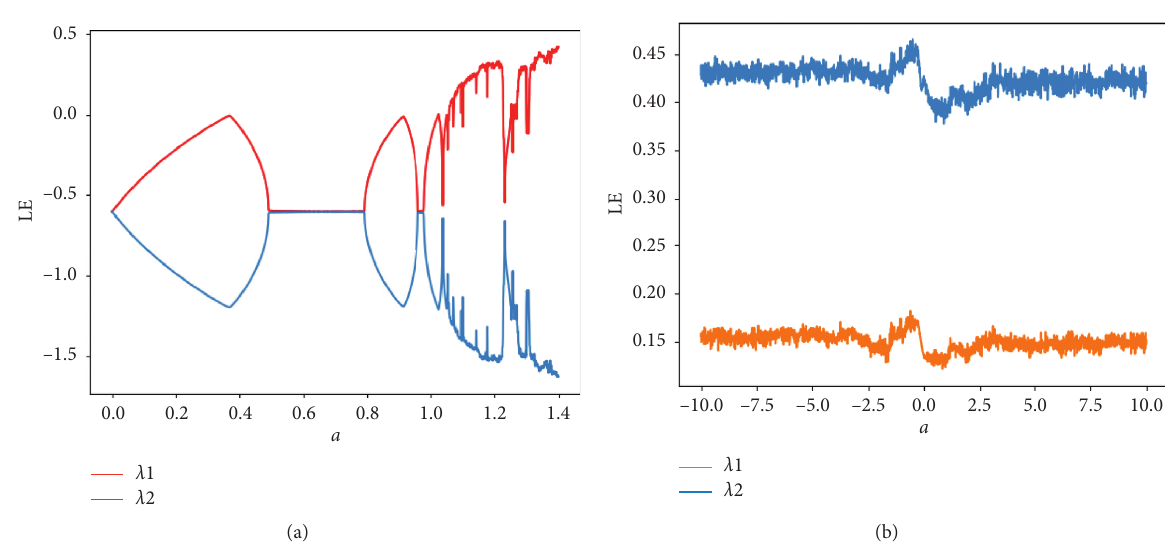
Figure 6: The Lyapunov exponents diagram of (a) Henon; (b)